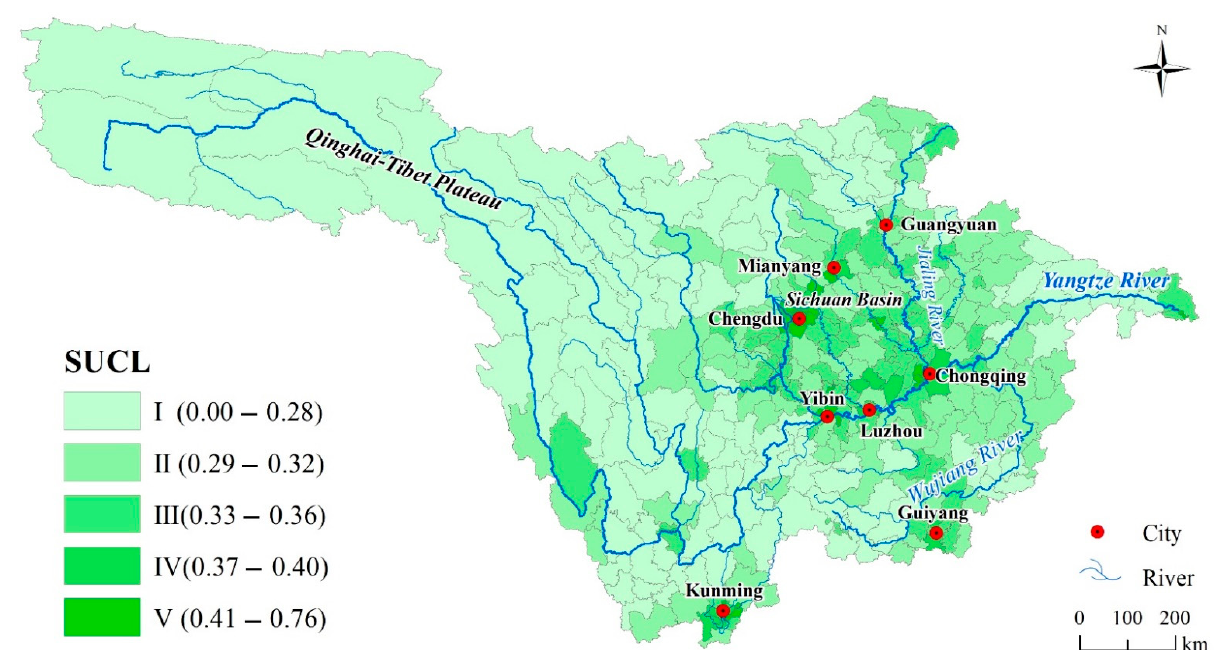
Figure 4. Results of comprehensive evaluation and spatial pattern of suitability of urban construction land (SUCL).